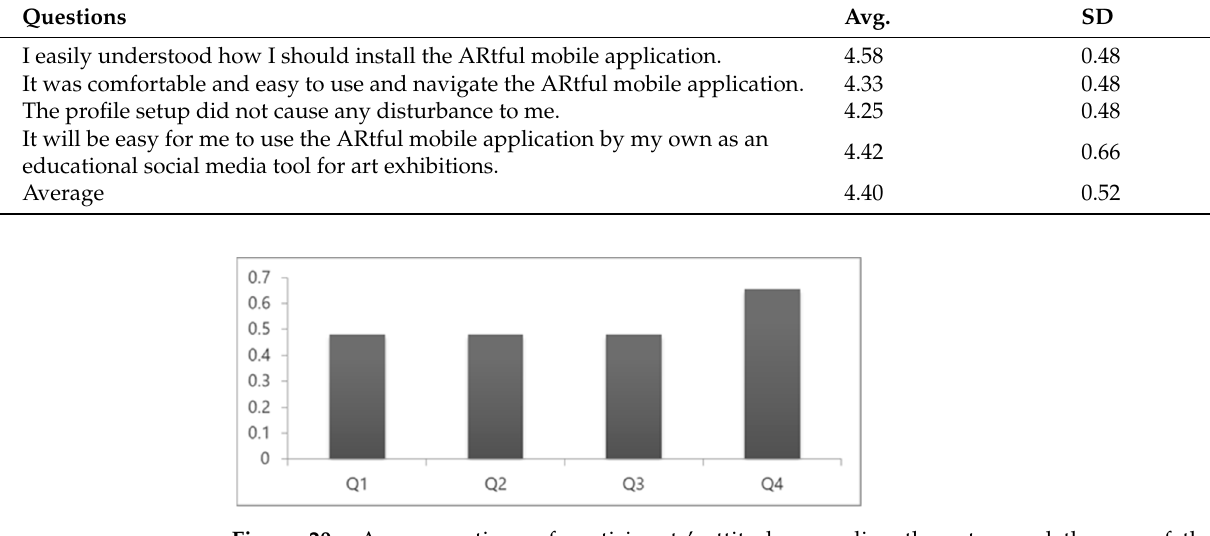
Figure 20. Average ratings of participants’ attitude regarding the setup and the use of the proposed app.